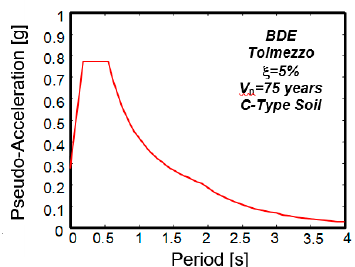
Figure 10. BDE-scaled pseudo-acceleration response spectrum for Tolmezzo.